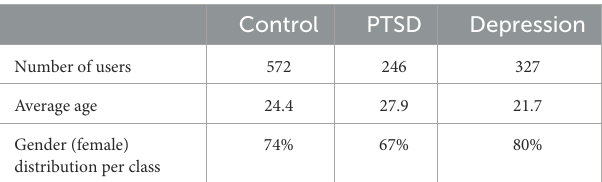
TABLE 5 CLPsych 2015 shared task dataset